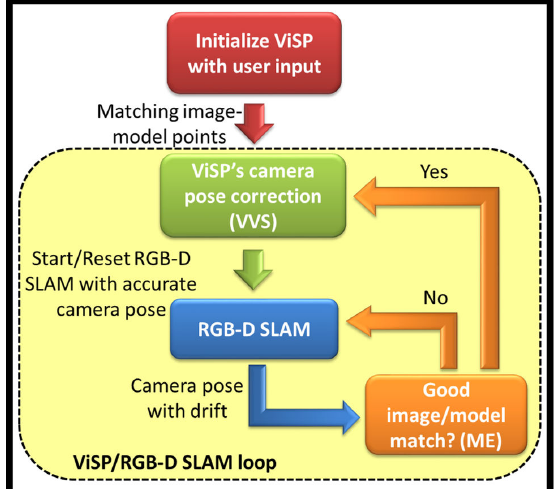
Figure 7. ViSP / RGB-D SLAM integration workflow.